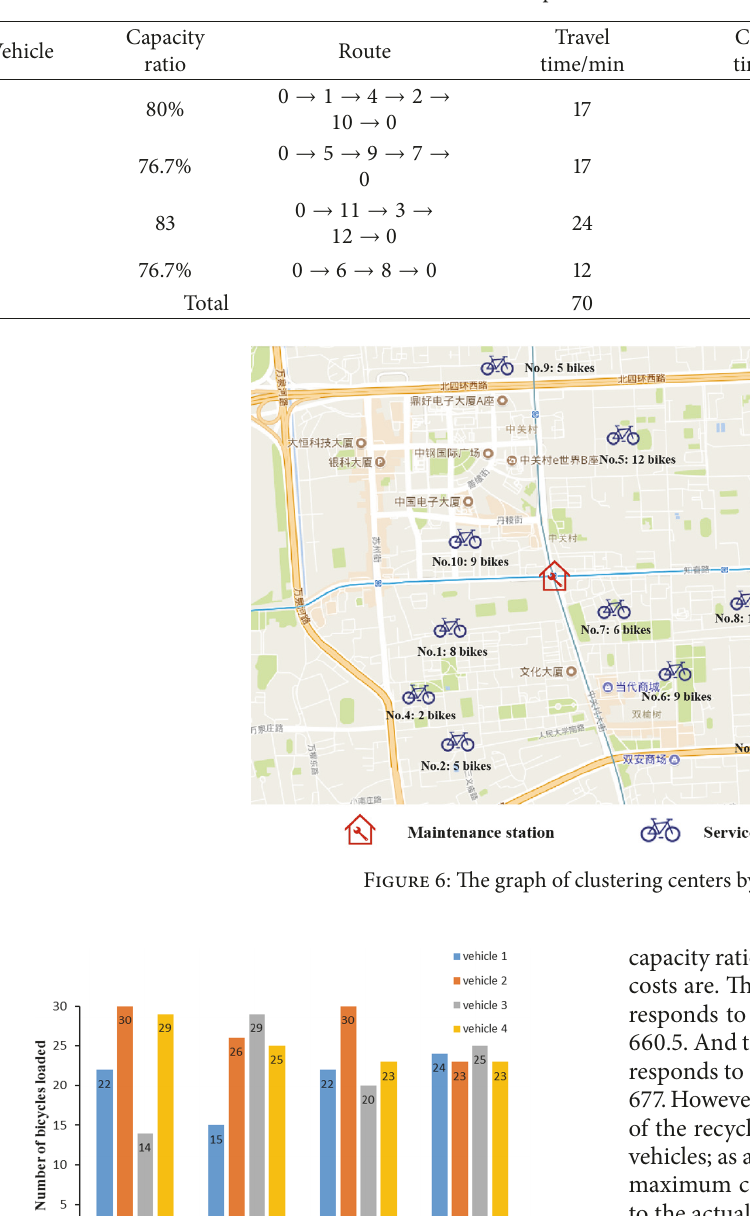
Table 1: The optimal result of FBSP model.